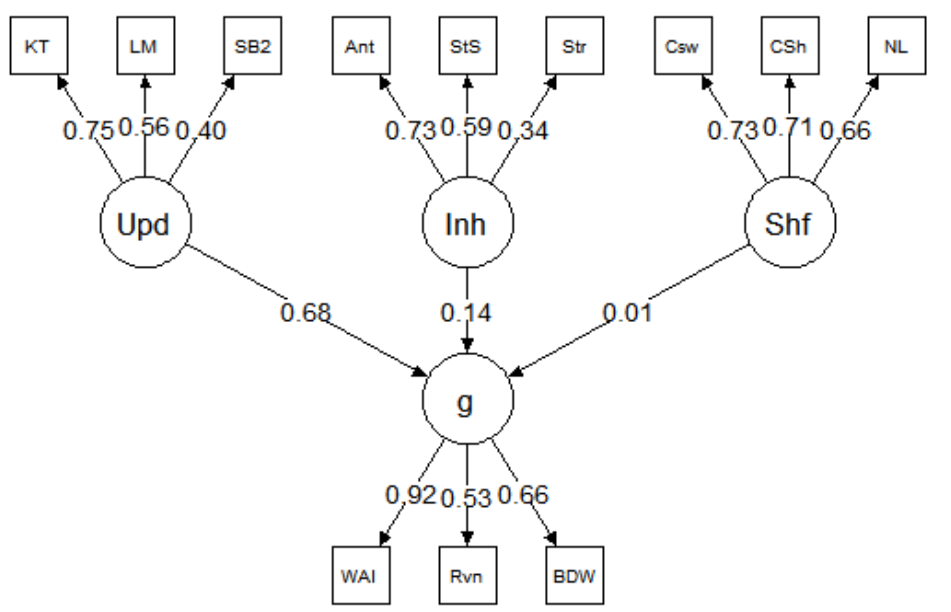
Figure 5. Reanalysis of Benedek et al. (2014). Inh = inhibition; Upd = updating; Shf = shifting; NIR = numerical inductive reasoning; VDR = verbal deductive reasoning.